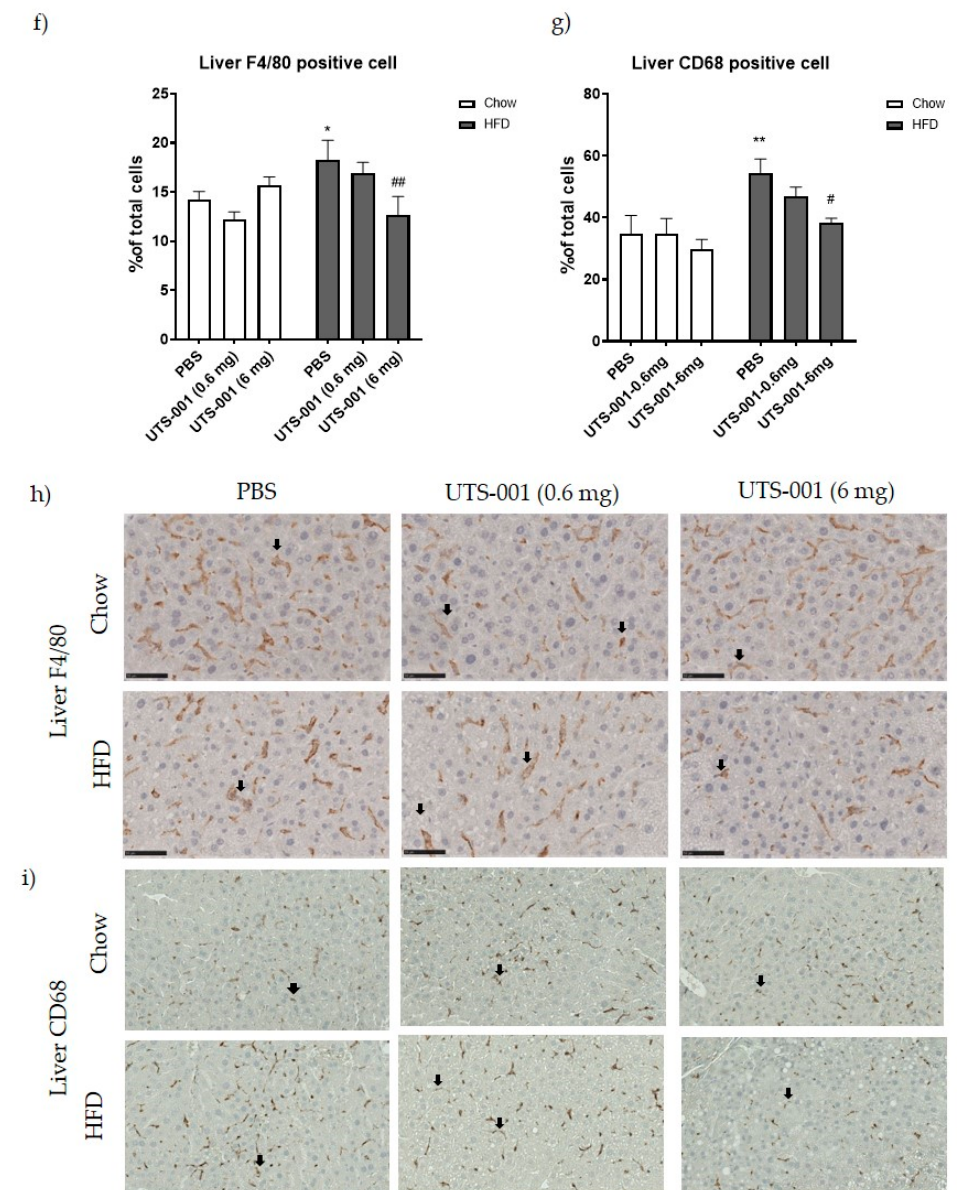
Figure 2. Liver mRNA expression of inflammatory markers ( a ) TNF- α , ( b ) IL-6, ( c ) MCP-1, ( d ) TLR-4, ( e ) IL-1 β . Percentage of macrophage number as identified by ( f ) F4/80 and ( g ) CD68 immunohistochemistry staining and ( h ) and ( i ) respective representative images were taken at 10× magnification. Positive staining indicated by arrows in h and i. Data are represented as mean ± S.E.M and were analysed using two-way ANOVA followed by post hoc Fischer’s LSD test, n = 5–9. * p < 0.05 vs. Chow-PBS; ** p < 0.01 vs. Chow-PBS; # p < 0.05 vs. HFD-PBS; ## p < 0.01 vs. HFD-PBS.